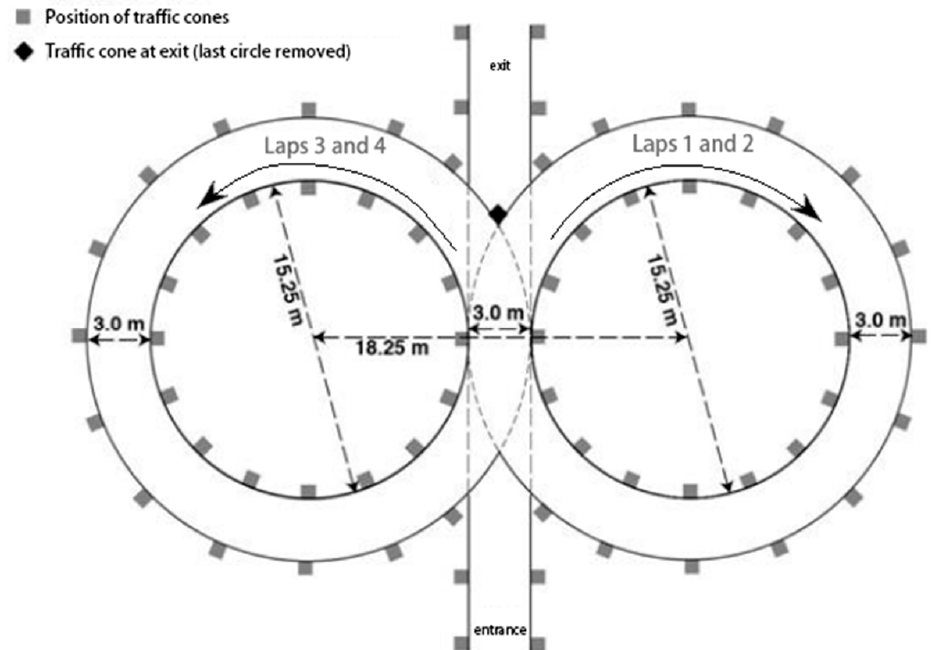
Figure 21. Figure-eight surround test layout.